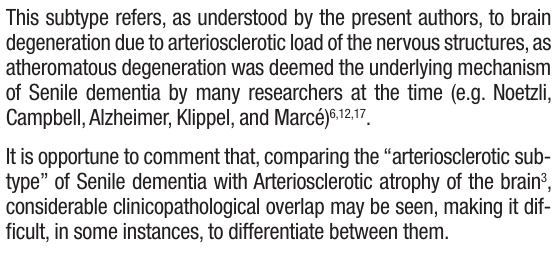
Box 1. Excerpts on the neuropathology of Senile dementia, based on Campbell’s paper. 6,15 The pathological aspects of Senile dementia were mostly based on the detailed examination of the histologic changes reported by Campbell’s paper on the neuropathology of “aged insane”, a term that Alzheimer regarded as a comparable condition. The superficial layers of the cerebral cortex appeared densely fibril- lated, and the surface of the cerebral cortex showed abundant Cor- pora amylacea, especially numerous in the external medullary lamina of Ammon’s horn. He also described the occurrence of numerous spi- der cells ( Spinnenzellen, astrocytes) in the superior layers, viewed as an almost characteristic sign of Senile dementia. He described small and evenly scattered gold yellowish pigment in the body of these cells or in their processes. Campbell believed they were almost a characteristic feature of “senile insanity” [Senile dementia] that could be differentiated from those found in Paralysis. A widespread degeneration of the cortical neurons, in all stages of breakdown, could be observed. The cells showed typically a pigmen- tary degeneration, which affected nerve cells of all sizes, in which protoplasm was entirely replaced by the pigment, and amorphous clusters dispersed in the tissue (matrix) showed the final remains of the pigmentary degeneration, indicating the position of a former nerve cell, now disintegrated (*) . The constituents of the cortical blood vessels could not be clearly dis- tinguished. The microscopic changes were distinctive, with marked arteritis chronica deformans , embolic, and thrombotic softenings, perivascular hemorrhages, with destruction of the surrounding tis- sue in the basal nuclei and in the pons Varolii, common changes in morbid senescence. The perivascular spaces were mostly dilated, particularly in the sections through the basal ganglia ( état criblé, ac- cording Durand-Fardel, 1854). The macroscopic changes of the brain comprised atrophy and de- crease in weight, thinned convolutions, wide, shallow, open sulci. The frontal segment invariably suffered most change. The surface of the cerebrum was generally firm, sometimes slightly puckered. On sectioning, the cortex appeared shallow, dark in color, with indistinct striation, and the white matter was atrophied in proportion to the surface atrophy. The ventricles were always greatly expanded with an excess of fluid (“hydrocephalus ex vacuo”). (*) Concerning this microscopic description. it should be noted that at the time, specific silver staining techniques were not yet available, therefore the description must be interpreted with